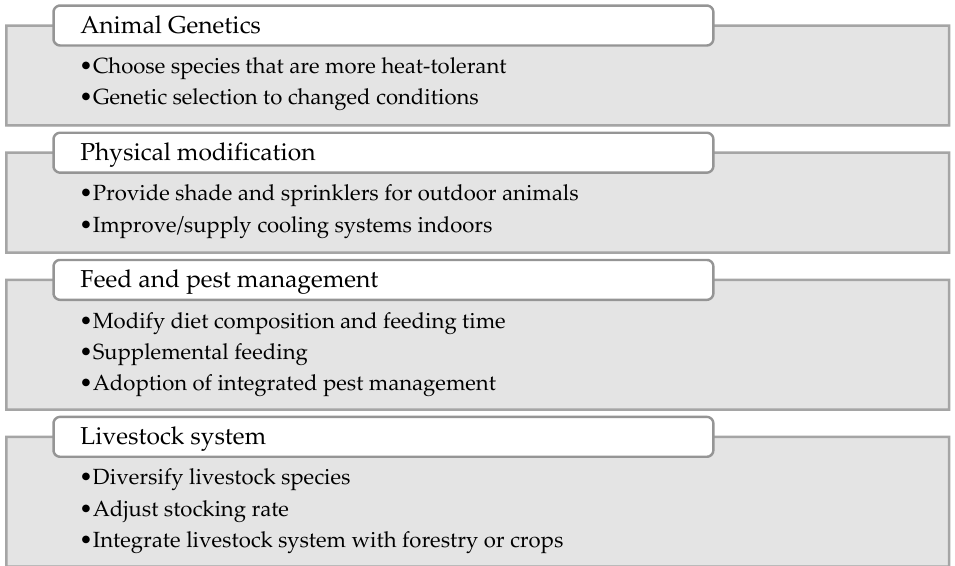
Table 3. Summary of human adaptation strategies.